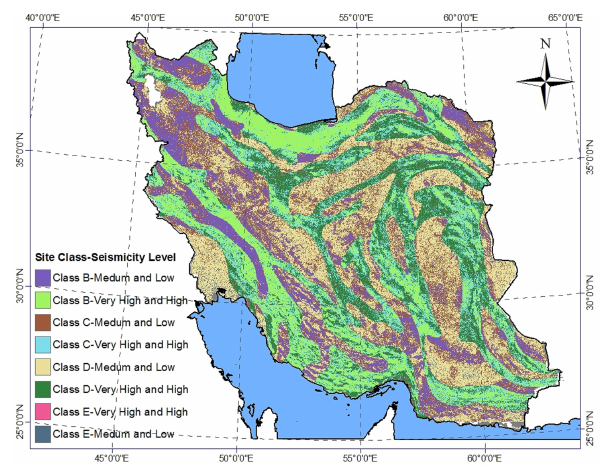
Figure 5. Soil class and seismicity level map of Iran.